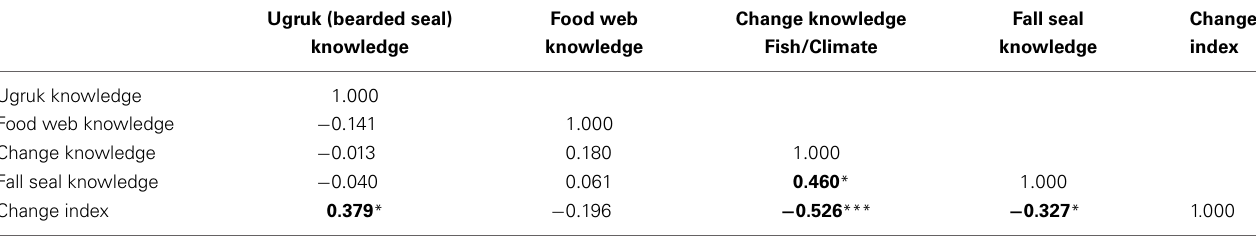
Table 5 | Relationships among cultural ecological knowledge